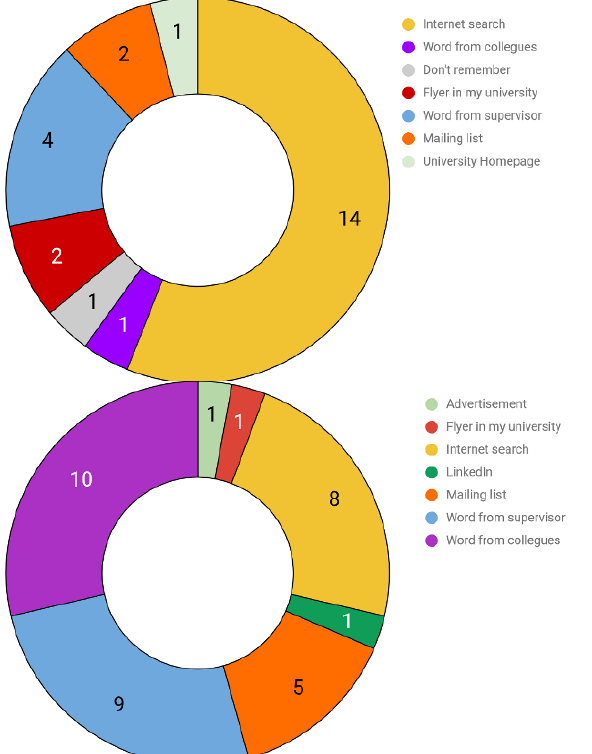
Figure 13. Distribution of how scholars learned about the summer school: from past 2017 edition (top) and 2019 edition (bottom).